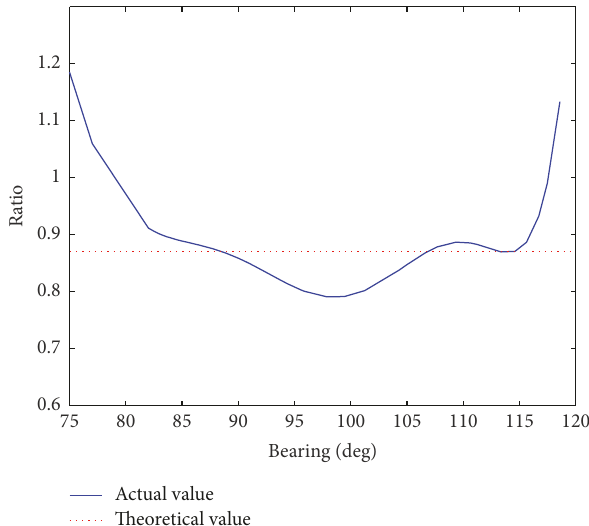
Figure 4: RCS ratio of two frequencies for one target.